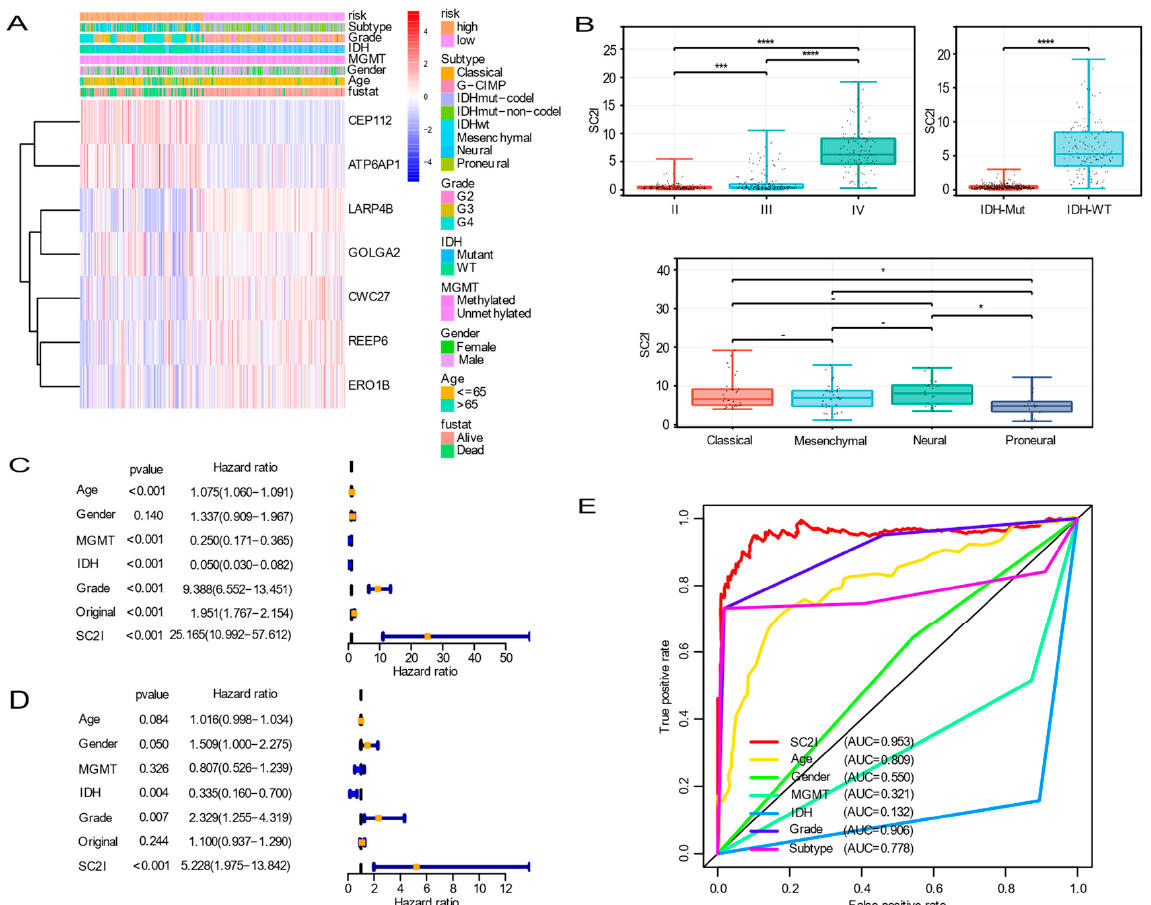
Figure 4. Correlation between SC2I and clinicopathological characteristics in TCGA dataset. ( A ) Heatmap of correlation between risk groups and subtype, WHO grade, IDH mutation status, MGMT promoter status, gender, age, survival status, and mRNA expression of SARS-CoV-2-related gene. ( B ) Different distribution of SC2Is among glioma subgroups ( C , D ) Univariate and multivariate COX regression analysis of the combination of SC2I and clinicopathological characteristics. ( E ) ROC curves of SC2I and clinicopathological characteristics. SC2I, SARS-CoV-2 index; TCGA, The Cancer Genome Atlas; IDH, isocitrate dehydrogenase; MGMT, O 6 -methylguanyl DNA methyltransferase; ROC, receiver operating characteristic. * p < 0.05, *** p < 0.001, **** p <